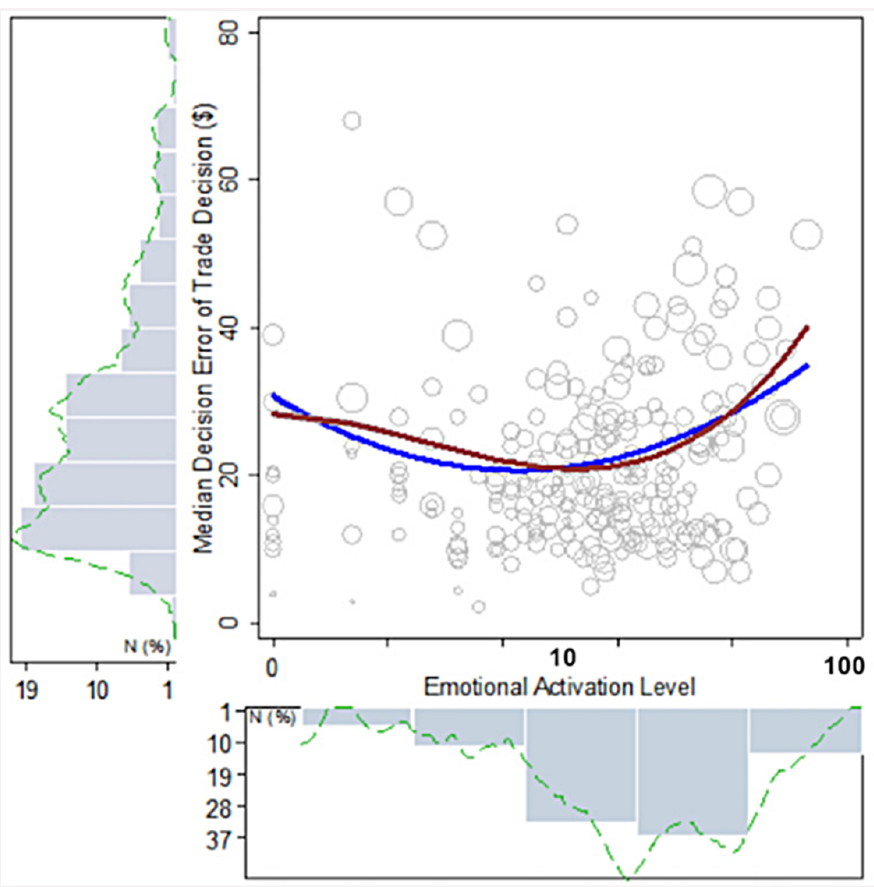
Fig 4. Daily Online Emotional Activation and Daily Median Decision Errors in Stock Trading Decisions. The figure shows the relationship between emotional activation and stock trading decision errors for trader #7. Size of scatter points represent the number of observations. The red line is a non-parametric lowess spline fit and the blue line is a quadratic fit. Plots for each trader are shown in the S1